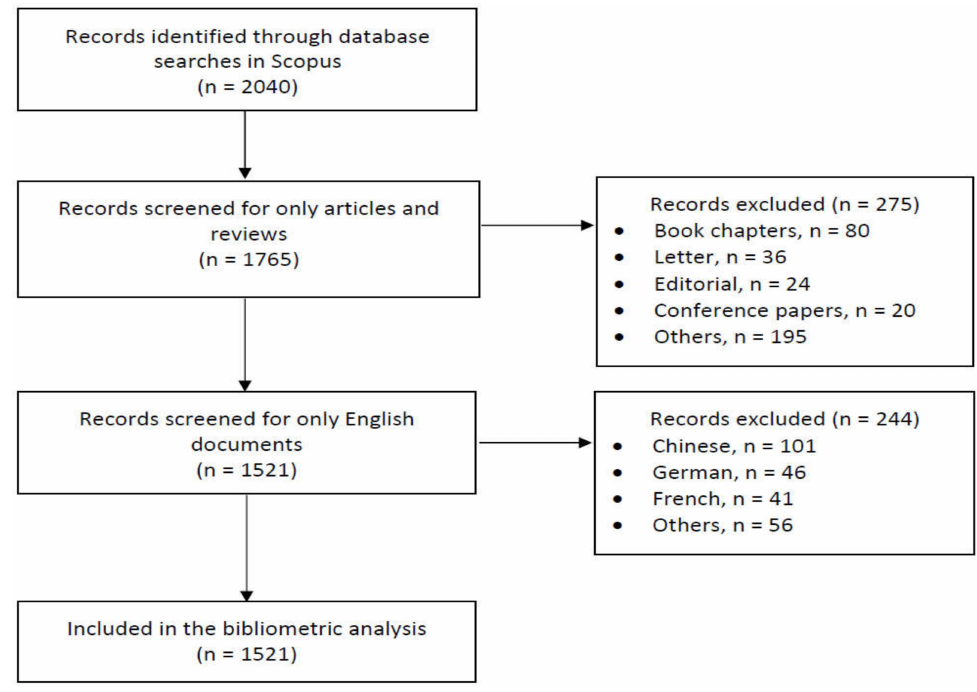
Figure 1. Flow diagram for the bibliometric